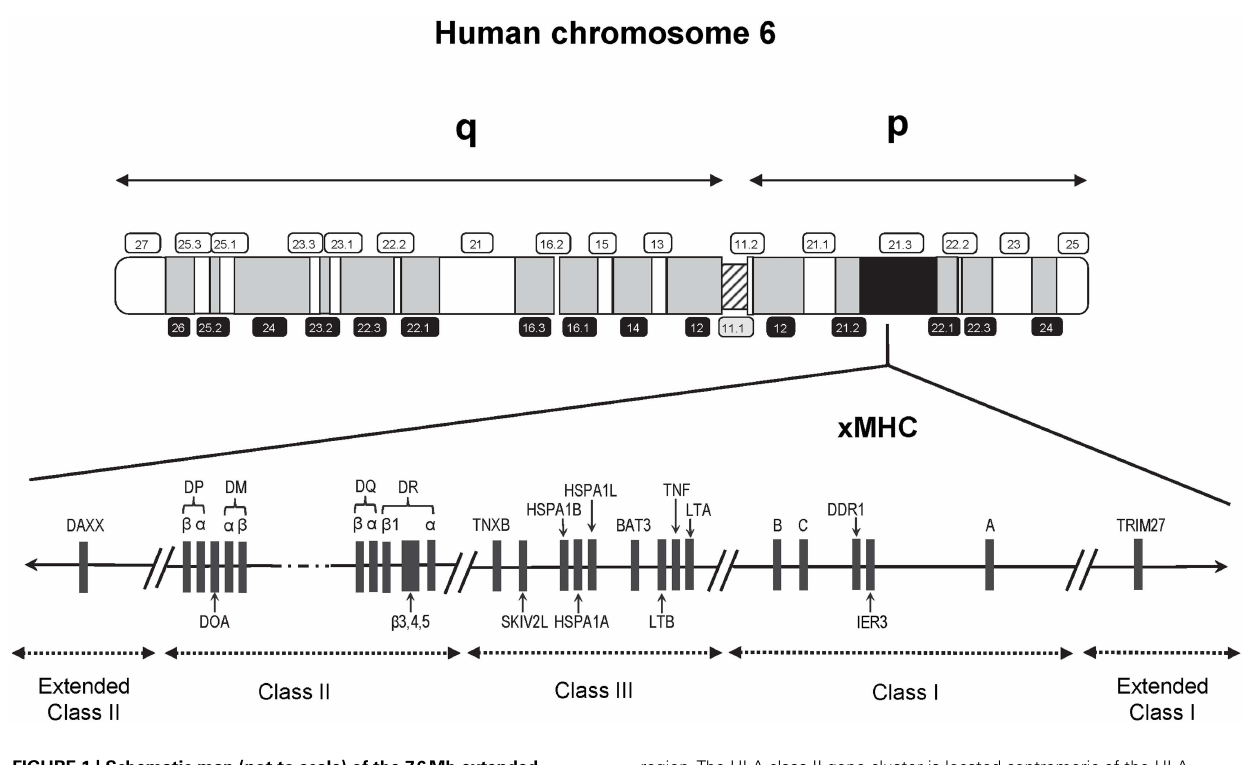
FIGURE 1 | Schematic map (not to scale) of the 7.6Mb extended human MHC (xMHC) on the short (p) arm of human chromosome 6 . The HLA class I gene cluster includes the three expressed classical class I genes, HLA-A , HLA-B , and HLA-C , and is located telomeric of the class III